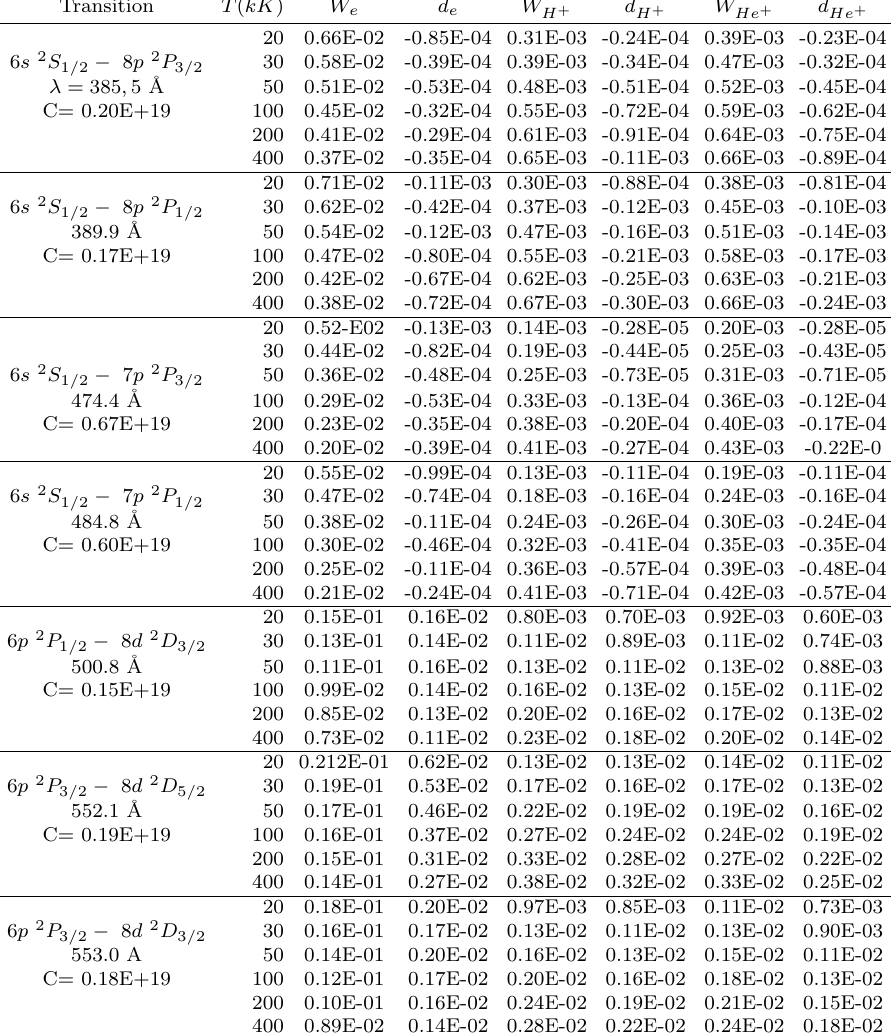
Table 1. This table gives electron, proton and singly-charged helium impact broadening parameters for Pb IV lines, for a perturber density of 10 17 cm (cid:0) 3 and temperatures in the range of 20 000 to 400 000 K. Transitions, wavelengths (in (cid:23)A) and the parameter C are also given. This parameter when divided to the corresponding Stark width gives an estimate for the maximal perturber density for which the line may be treated as isolated. W e is the electron-impact full Stark width at half maximum, d e is the electron-impact Stark shift, W is the proton-impact full Stark width at half maximum, d is the H + H + is the singly charged helium-impact full Stark width proton-impact Stark shift, W He + at half maximum, d is the singly charged helium-impact Stark He +